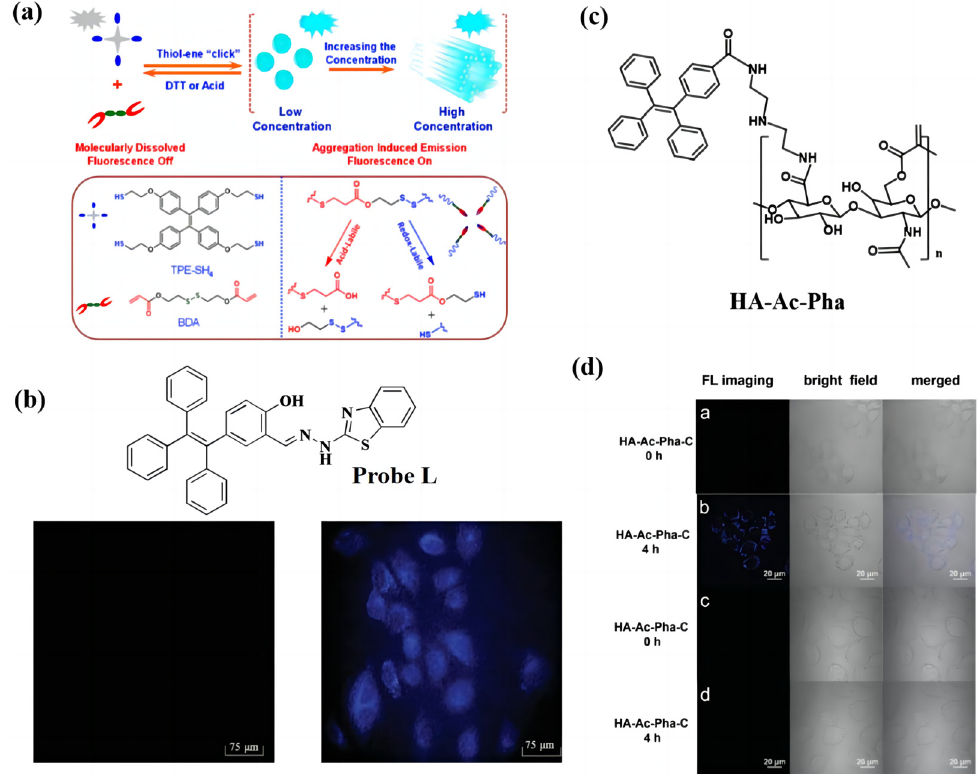
Figure 3. ( a ) Molecular structure of TPE-SH 4. ( b ) Molecular structure of probe L and Fluorescence image of HeLa cells incubated with pure L (10 µ M) and L + Zn 2+ (100 µ M). Adapted with permission from [60]. ( c ) Molecular structure of HA-Ac-Pha. ( d ) LSCM images of cells, which were excited by a 405 nm laser. The HeLa cells were incubated with 40 µ g mL − 1 of HA-Ac-Pha-C for 0 h and 4 h. The L929 cells were incubated with 40 µ g mL − 1 of HA-Ac-Pha-C for 0 h and 4 h. Adapted with permission from [61].